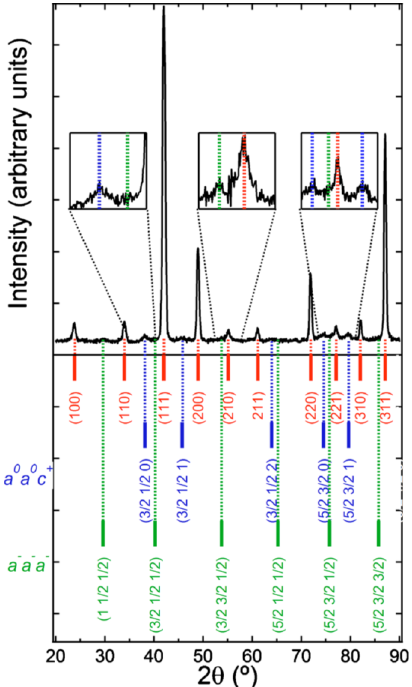
Figure 20. High resolution neutron powder diffraction pattern collected at a wavelength of 1.622 Å. Peak indexing shows contributions from the a 0 a 0 c + ( P 4b m ) and a − a − a − ( R 3 c ) tilt ‐ systems, respectively. Reproduced with permission from [5].